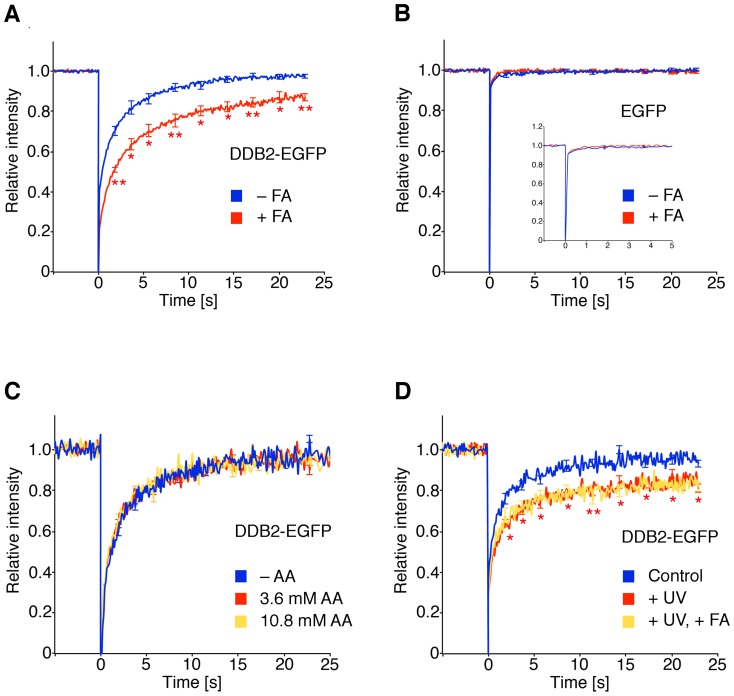
Delayed nuclear trafficking of UV-DDB.(A) FRAP analysis in human fibroblasts. Cells were transfected with DDB2-EGFP, incubated for 18 h with 75 μM formaldehyde (FA) and analyzed by FRAP (N = 50; error bars, S.E.M.). The fluorescence recovery curves were compared to those of untreated controls (*p<0.05; **p<0.01). (B) FRAP studies (N = 15; error bars, S.E.M.) demonstrating that EGFP movements are not affected by formaldehyde (18 h, 75 μM). (C) FRAP analysis with analogous acetaldehyde (AA) treatments (N = 50). (D) Combined formaldehyde and UV treatment. Transfected human fibroblasts were exposed to 75 μM formaldehyde for 18 h, UV-irradiated (30 J/m2) and subjected to FRAP analysis (N = 30). The asterisks indicate significant differences between UV-damaged fibroblasts and untreated controls (*p<0.05; **p<0.01).